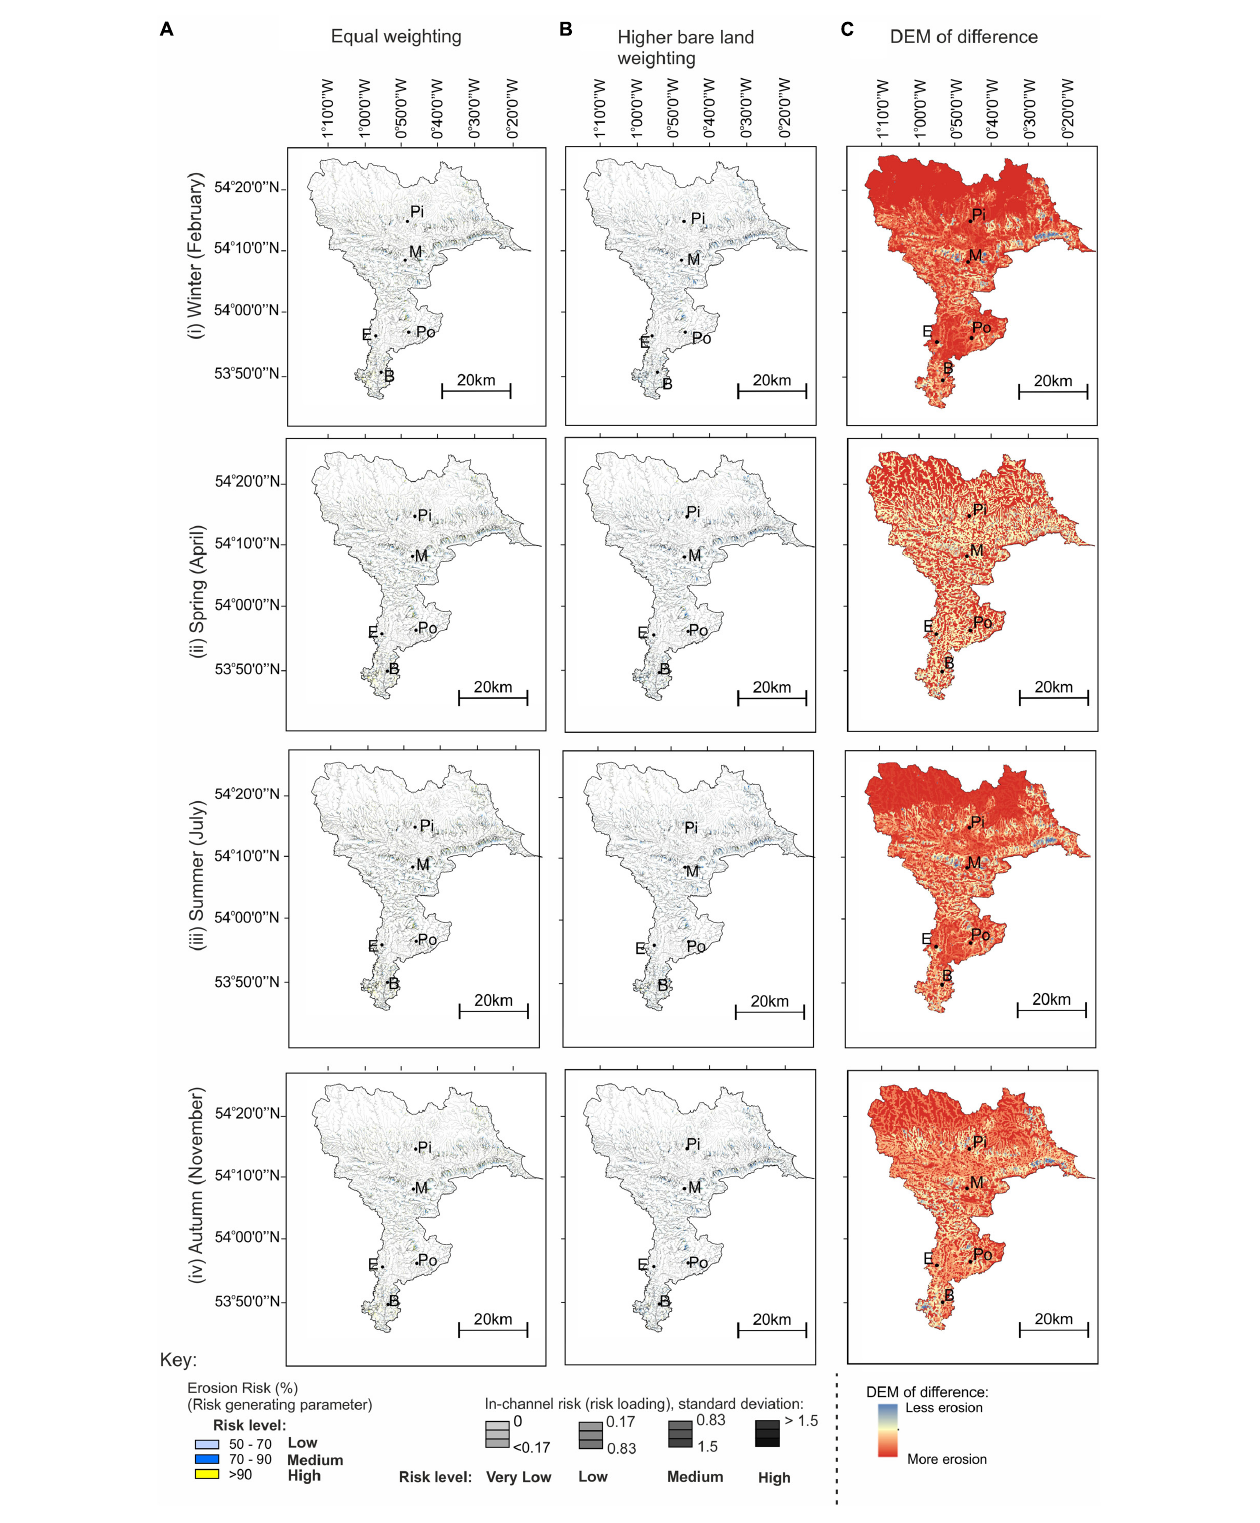
FIGURE 8 | Model scenario showing change in erosion risk across the seasons: (i) Winter; (ii) Spring; (iii) summer; (iv) Autumn, when (A) agricultural land and bare land have the same erosion risk assigned; (B) when erosion risk in bare land is higher and (C) the DEM of difference. Locations are shown on each map; Pi, Pickering; M, Malton; Po, Pocklington; E, Elvington; B, Bubwith.